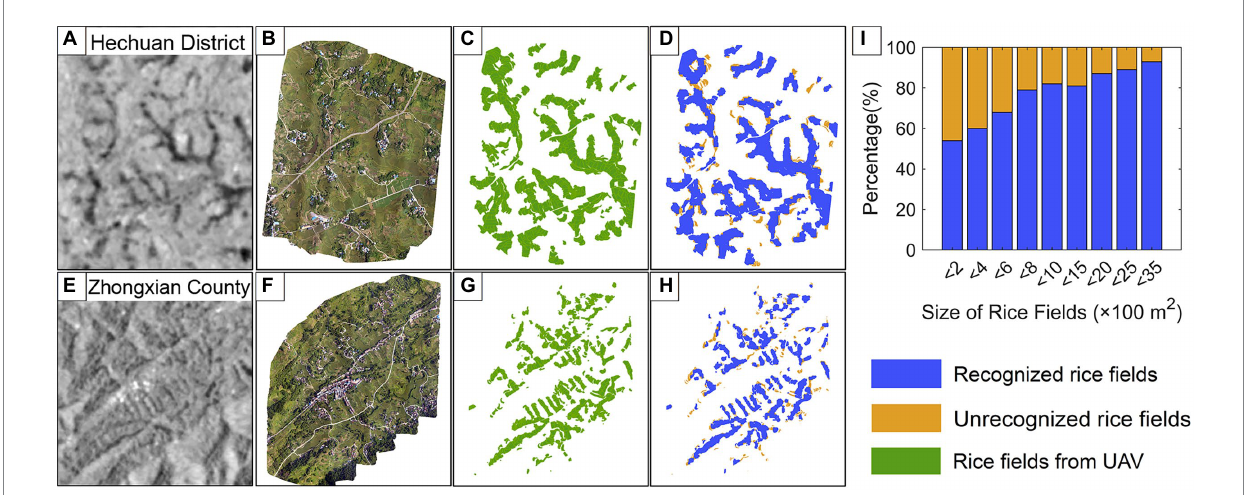
FIGURE 10 Accuracy assessment of rice fields map in two pilot regions based on UAV images. (A,E) Sentinel-1 VH images during rice transplanting stage. (B,F) UAV images in two pilot regions. (C,G) Real rice fields based on UAV images. (D,H) The recognized and unrecognized parts within each rice field for two pilot regions. (I) Proportions of recognized and unrecognized area with the changes of rice field sizes.